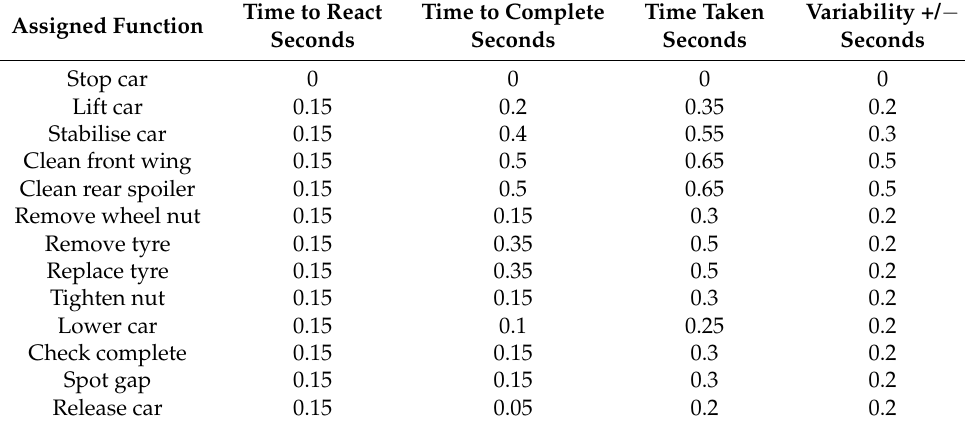
Table 3. F1 pit stop—Indicative timings of key functions